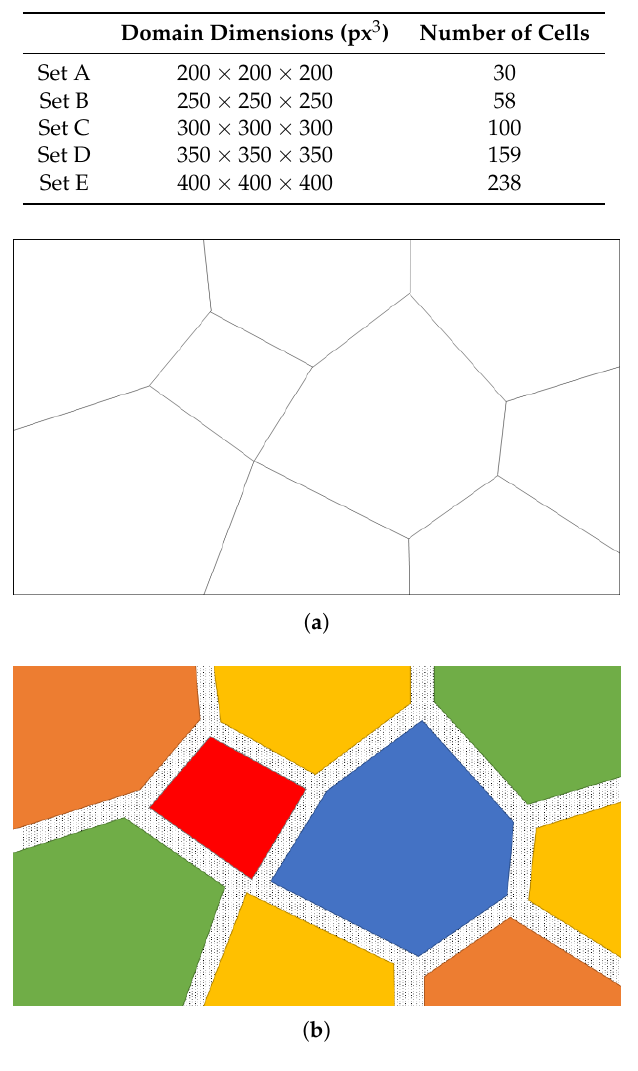
Figure 3. Original ( a ) and exploded ( b ) cell structure. The colors identify cells. The walls are pattern